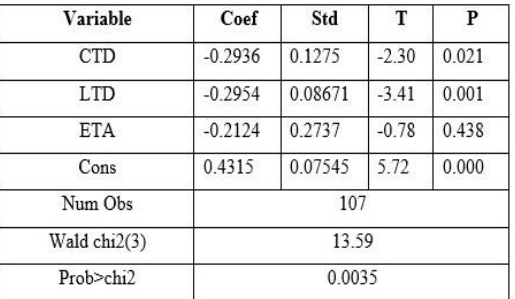
Table 5: Random-Effects GLS results